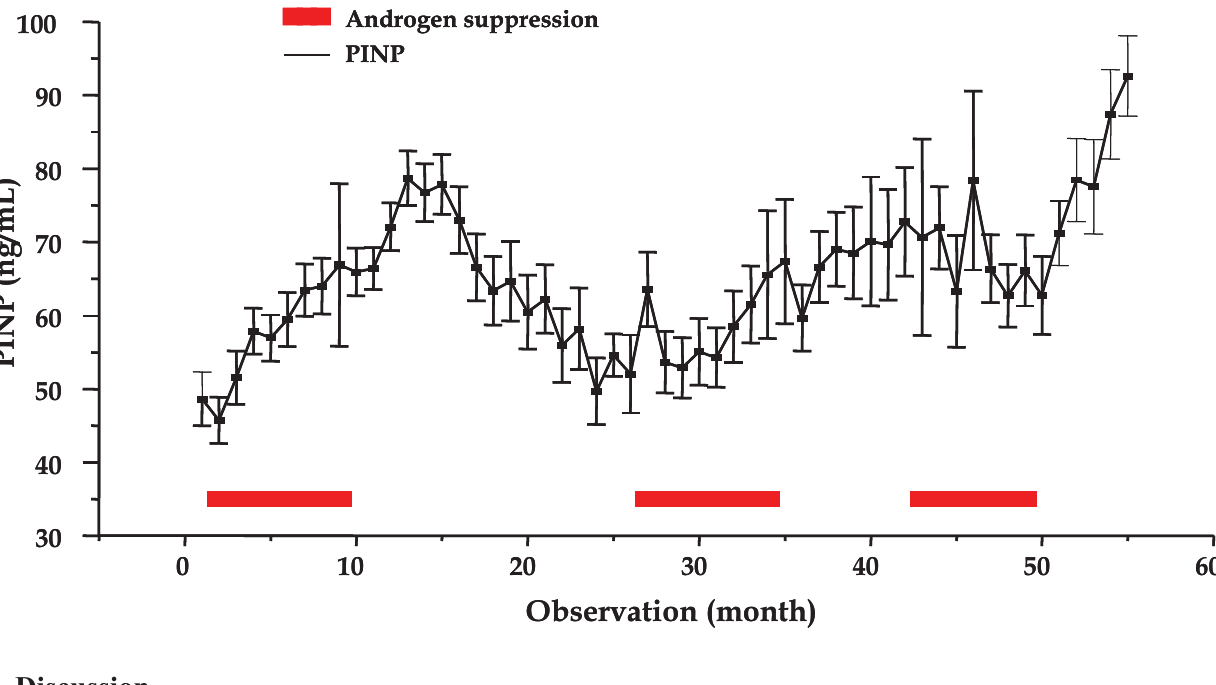
Figure 3. Mean time course of PINP levels over three IAS cycles of the prostate cancer patient group in total (observations monthly, mean values ± SEM). The three AS periods are indicated by red